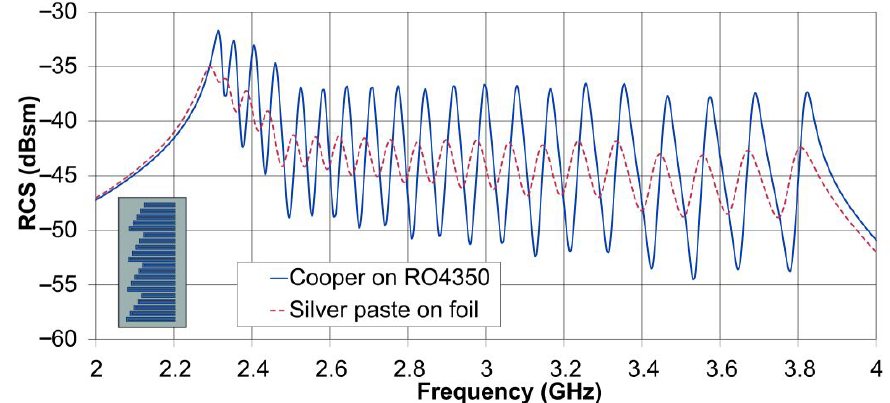
Figure 5. Simulated RCS of shorted re-arranged U-dipole tag.